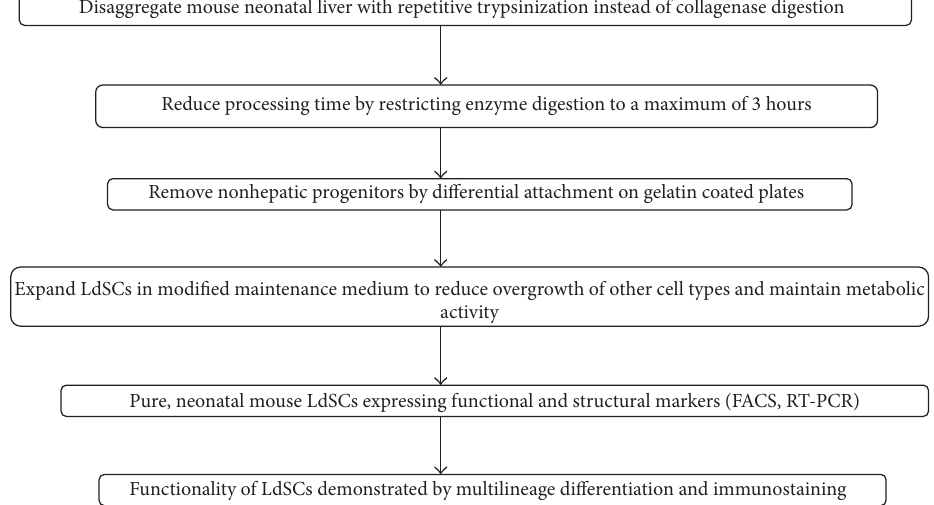
Figure 1: A schematic overview of the major steps followed in the isolation of LDSCs